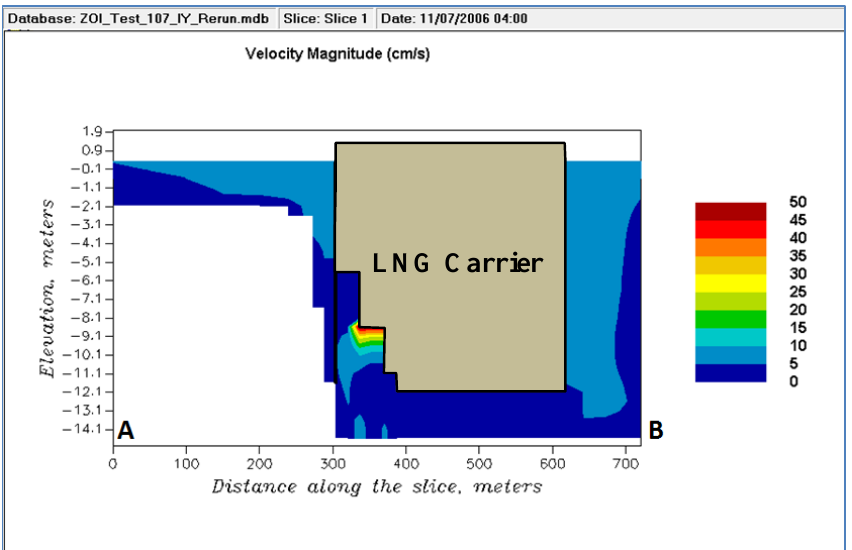
Figure 8. Velocity magnitude when intake is